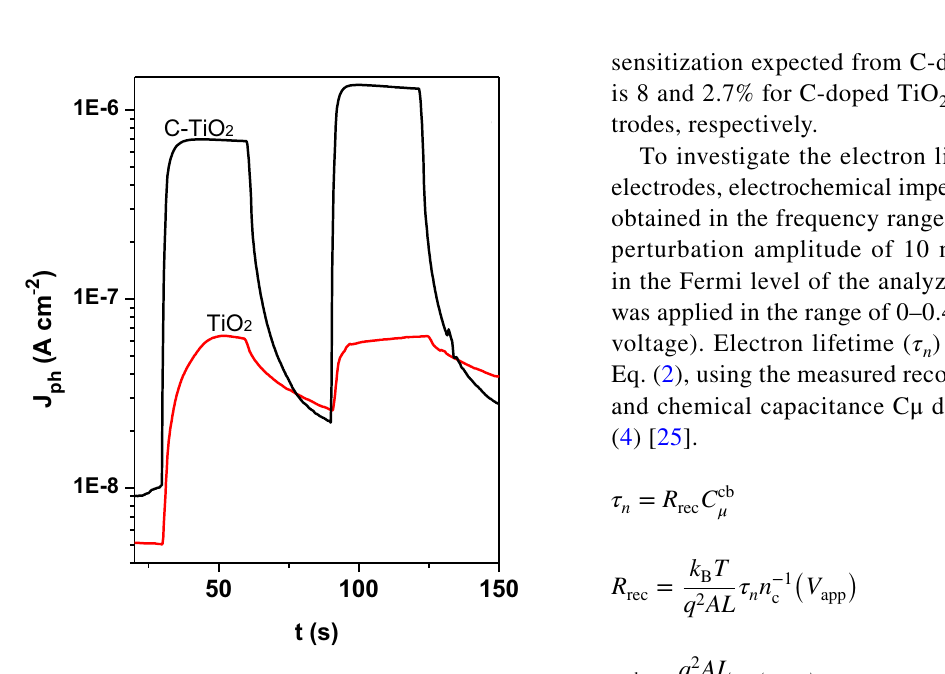
Fig. 3 Photoresponse measured at 0 V under 25 mA cm −2 illumina- tion intensity, C-doped TiO 2 (black), compact TiO 2